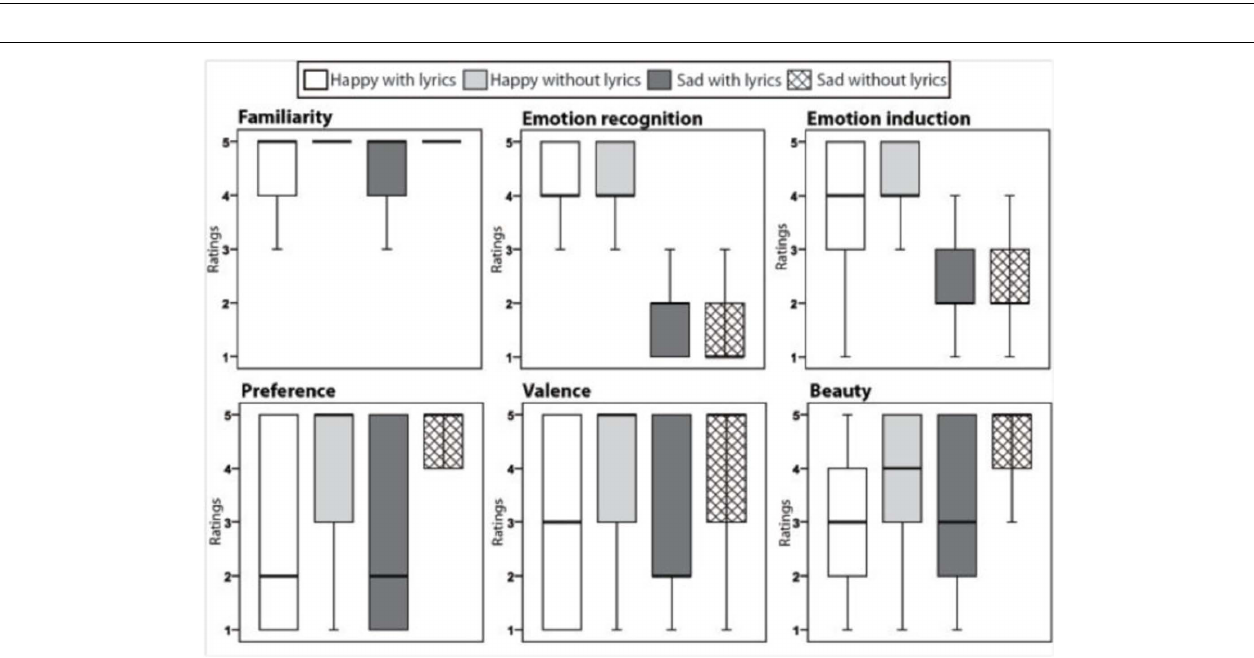
FIGURE 2 | Box plots with quartiles (upper values 75%, median 50%, and lower values 25%) for the ratings of each stimulus category and for each judgment scale. Outliers and extreme values are excluded.